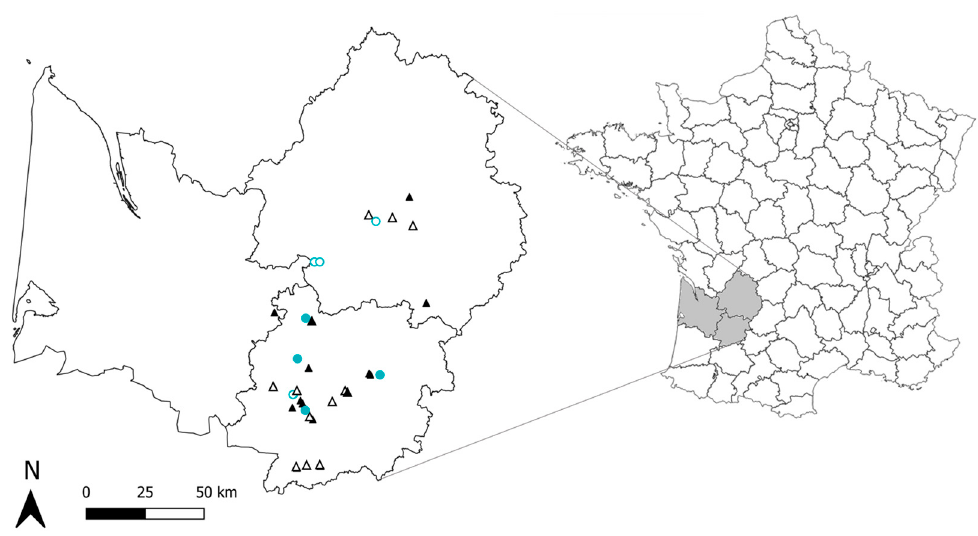
Figure 1. Location of the study area in France. Some sites being very close to each other, they are merged on the map. Black triangles represent greenhouse crops sampled at the two sampling sessions and blue circles represent greenhouse crops sampled only once. Empty symbols represent open greenhouses and solid symbols represent close greenhouses.